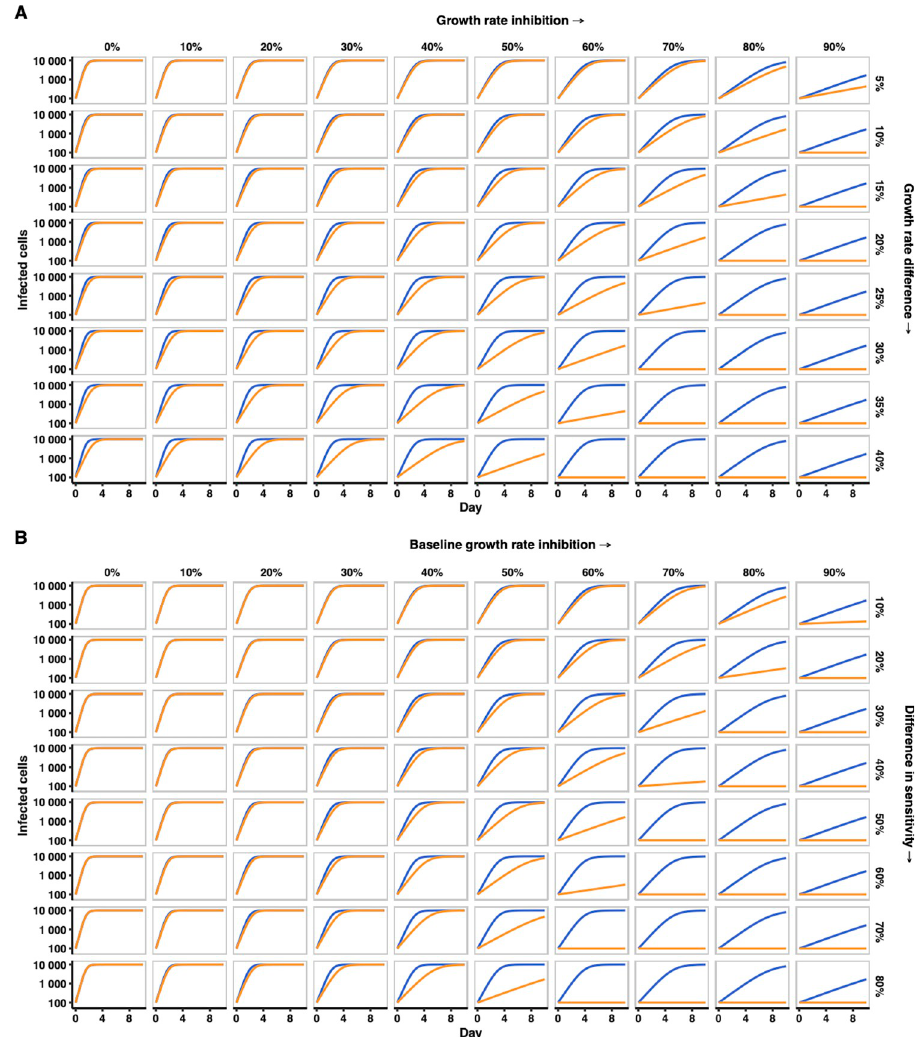
Fig 4. Illustrative simulations (in which a single parameter is varied) suggest that when assuming a simple logistic growth process, both small differences in growth rate between a virus pair, and differences in sensitivity to growth inhibition, can result in growth curves reminiscent of the relative interferon resistance of transmitted HIV-1 (observed in viral propagation experiments, such as those in Fig 1). (A) Illustrative logistic growth simulation of two viruses, where the growth rate of virus two (orange) is scaled relative to that of virus one (blue), while all other logistic growth parameters remain constant. Rows represent an increasing difference in growth rates between viruses (i.e., an increasing difference in replicative fitness). Both viruses experience the same relative growth rate inhibition (columns) mimicking increasing IFN stimulation. (B) Illustrative logistic simulations in which growth rates are identical, but virus two (orange) is more sensitive to the growth rate-inhibiting factor (i.e., one virus is more sensitive to antiviral effectors). Columns represent an increasing growth rate inhibition (mimicking increasing IFN stimulation), while rows represent an increasing difference in the sensitivity of the two viruses to that inhibition. As in (A), we assume that only growth rate is affected, with all other logistic growth parameters remaining constant between